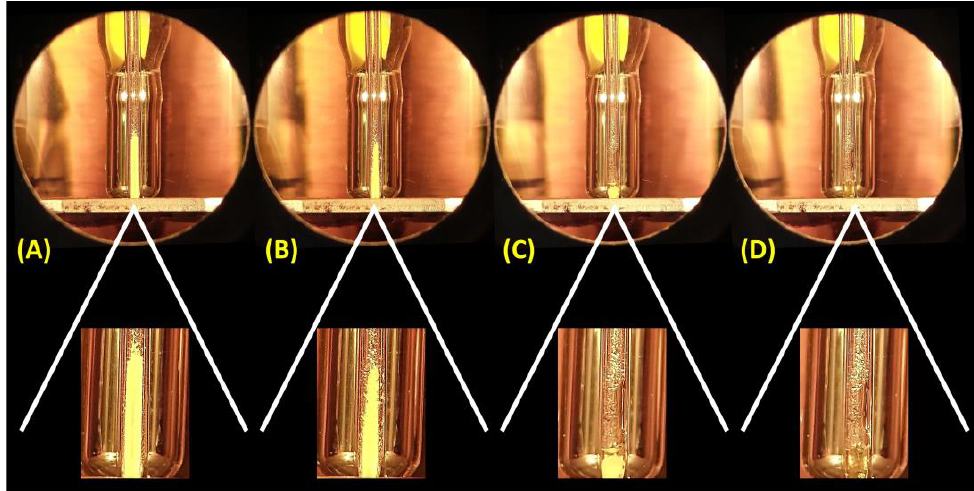
Figure 1. Pictures of a mp measurement of an MCR adduct using a common capillary-type melting range measuring instrument and respective expansions. From left to right: ( A ) sample before heating (1 °C min −1 ), (B) at the temperature of the collapse point, ( C ) the meniscus point, and ( D ) the clear point with small droplets also noted in the tube.